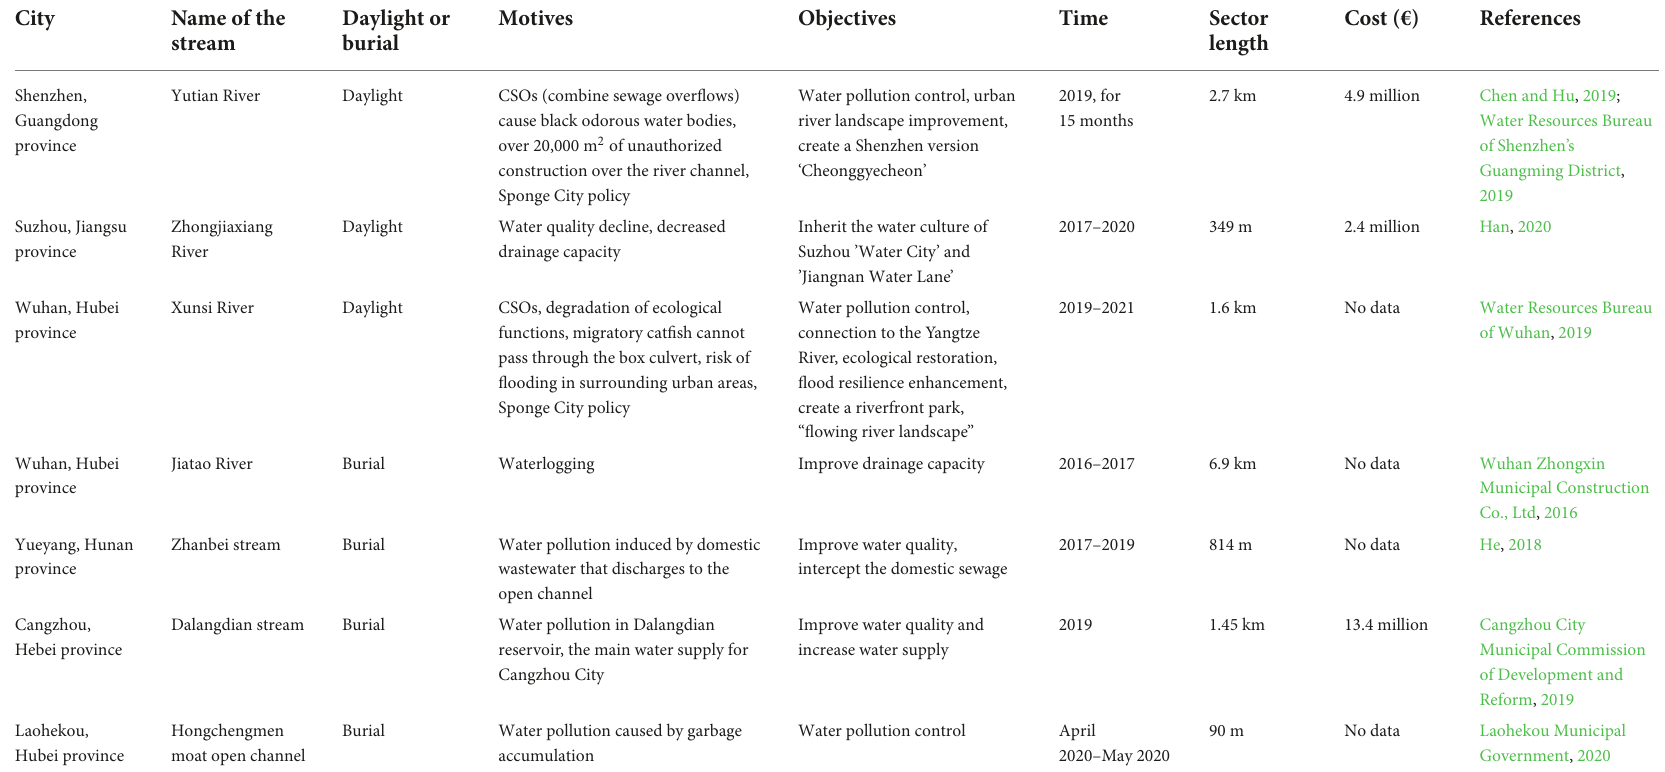
TABLE 5 Some of the recent examples of stream burial and daylighting in